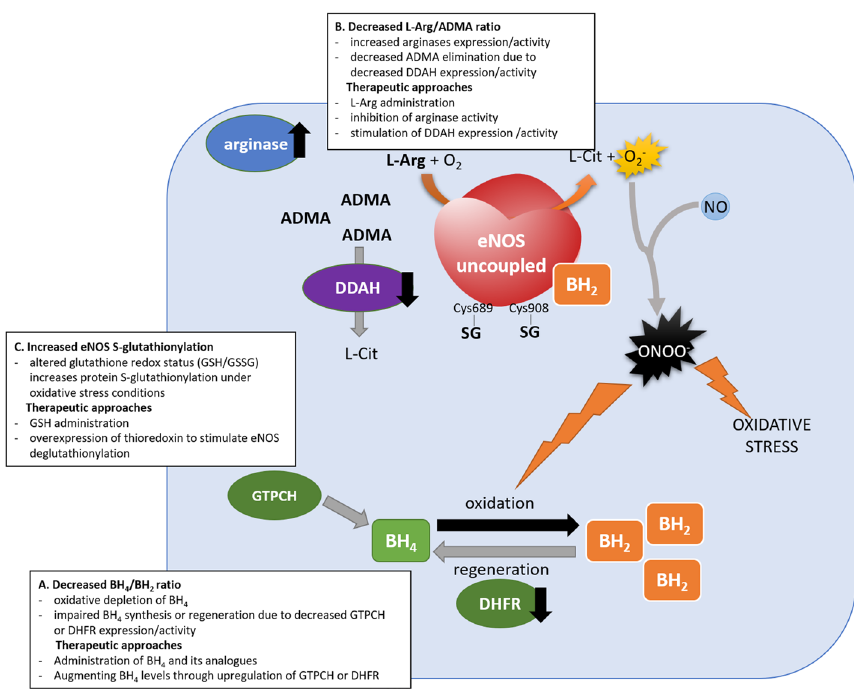
Fig. 5 Major causes of eNOS uncoupling as targets of potential therapeutic interventions. Oxidative stress associated with cardiovascular risk factors leads to eNOS uncoupling by: A decreased BH 4 /BH 2 ratio due to oxidation of BH 4 and impairment of DHFR expression/activity; B decreased L‑Arg/ADMA ratio due to excessive arginase expression/activity and diminished DDAH expression/activity; C eNOS S‑glutathionylation at Cys689 and